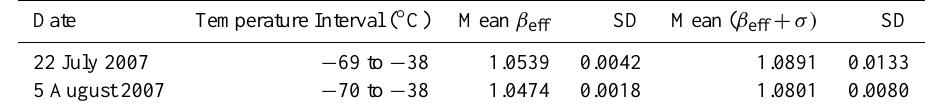
Table 1. Mean values of retrieved β eff and ( β eff + σ) , with corresponding values of their standard deviations (SD) for the two case studies. β eff is the effective 12-to-11µm absorption optical thickness ratio, and its SD at a given temperature is given by σ .